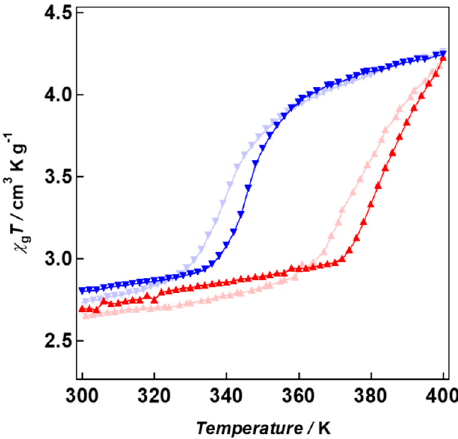
Figure 4. χ g T vs. T plots for composite 1 (heating: ( (cid:78) ); cooling: ( (cid:72) )) and composite 2 (heating: ( (cid:78) ); cooling: ( (cid:72) )).